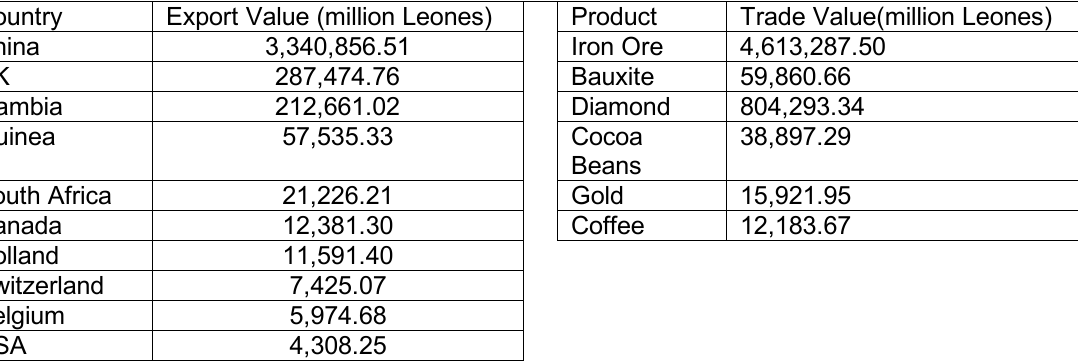
Table 1c: Export trading partners and products of Sierra Leone (Foreign Trade Statistics Bulletin – 2013) Country Export Value (million Leones) Product Trade Value(million Leones) China